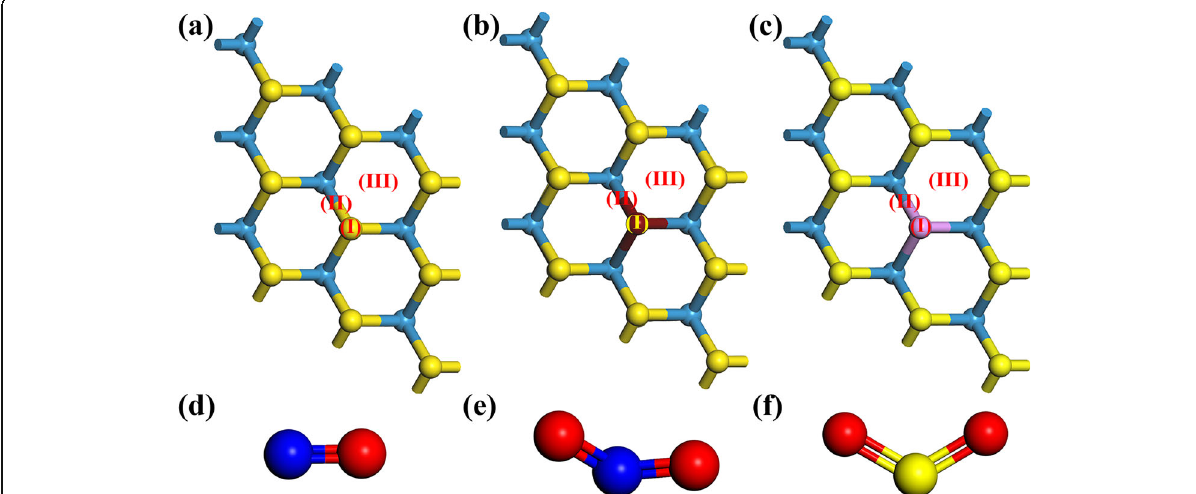
Fig. 1 The 4 × 4 × 1 supercell model of a pristine WS 2 , b Al-doped WS 2 , and c P-doped WS 2 with the three adsorption sites marked. And the models of d NO, e NO 2 , and f SO 2 molecules. Yellow, light blue, dark red, violet, blue, and red balls represent S, W, Al, P, N, and O,